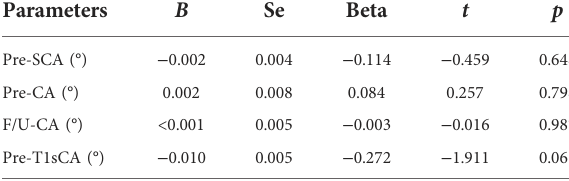
TABLE 6 Multivariate analysis of factors associated with